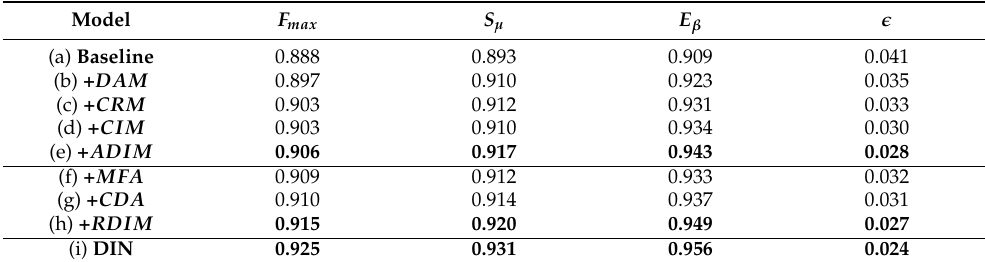
Table 4. Comparisons of ADIM and RDIM with other multi-modal fusion modules in the encoding and decoding stages,